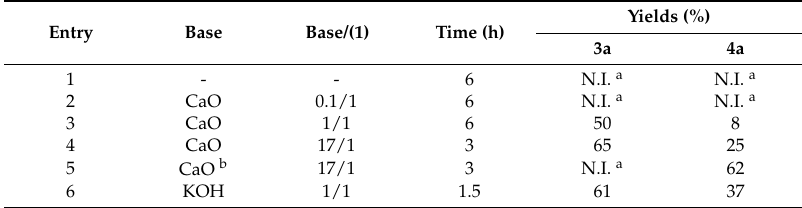
Figure 1. Gas chromatogram (GC) and mass spectra of compounds 3a , 4a and 5 .